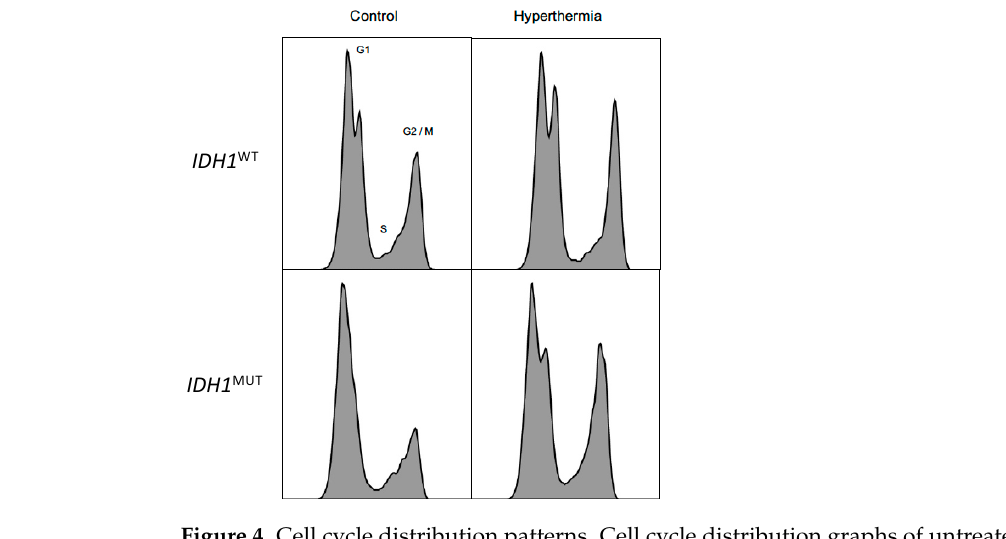
Figure 4. Cell cycle distribution patterns. Cell cycle distribution graphs of untreated (control) and hyperthermia treated IDH1 WT cells and IDH1 MUT HCT116 cells. IDH1 MUT and IDH1 WT HCT116 cancer cells responded similarly and went into cell cycle arrest (G2/M accumulation) after 1 h treatment with hyperthermia (42 °C).